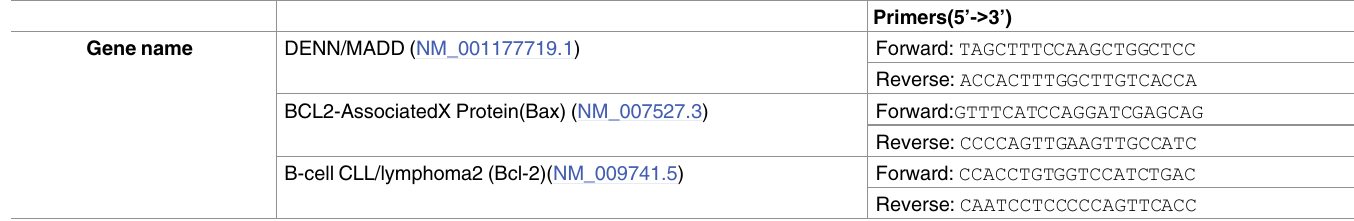
Table 1. Primer sets used in this